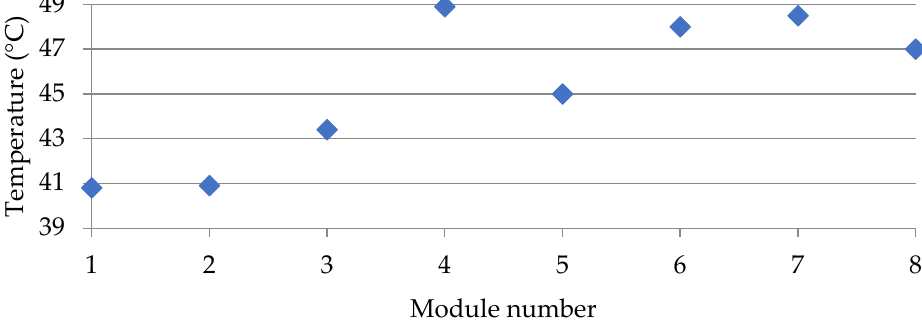
Table 13. Numerical data comparison of the thermographic analysis.